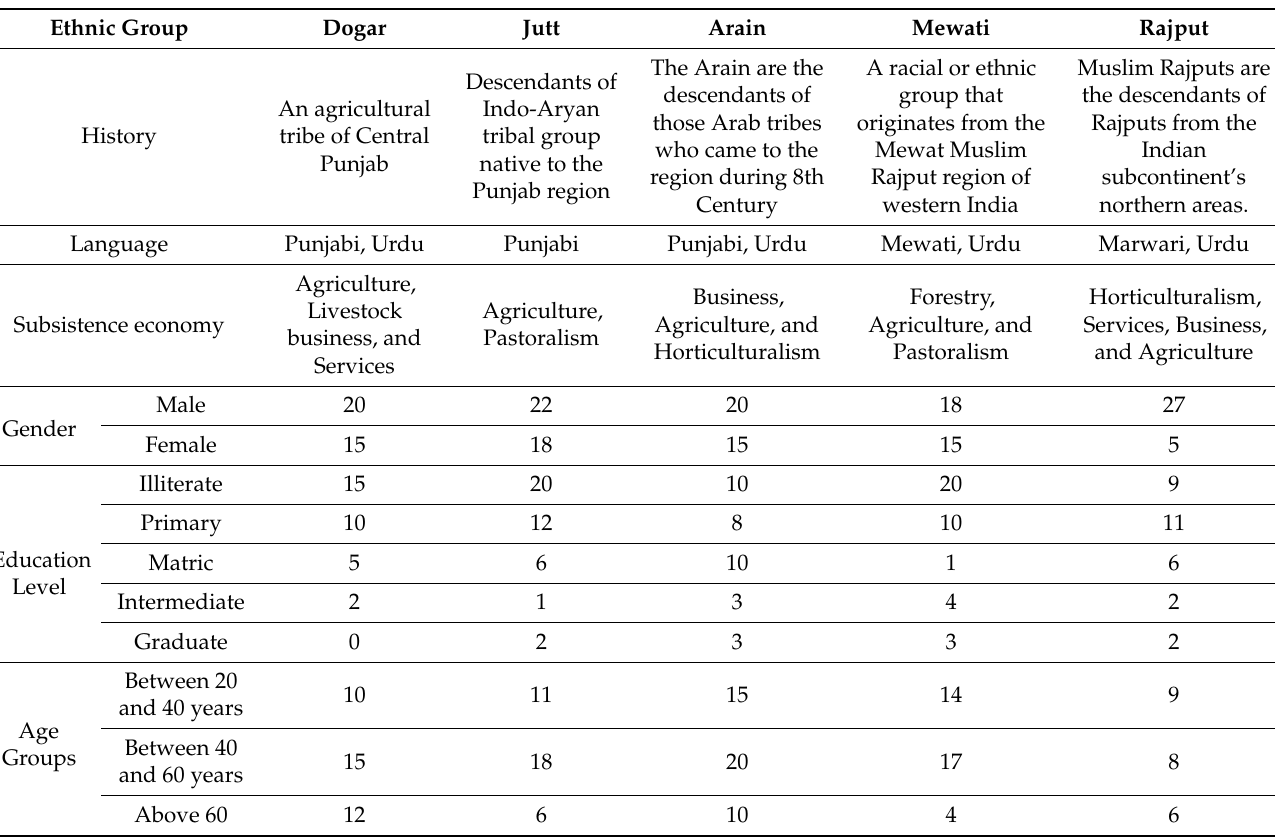
Table 1. Demography and sociocultural detail of